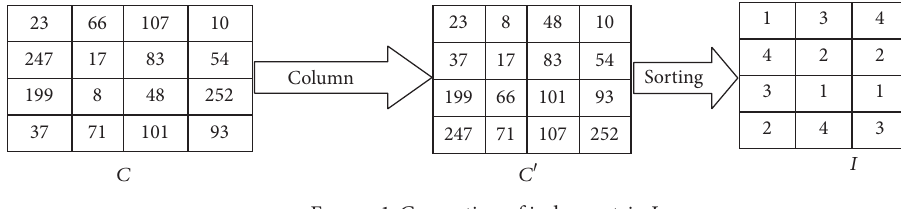
Figure 1: Generation of index matrix 𝐼 .